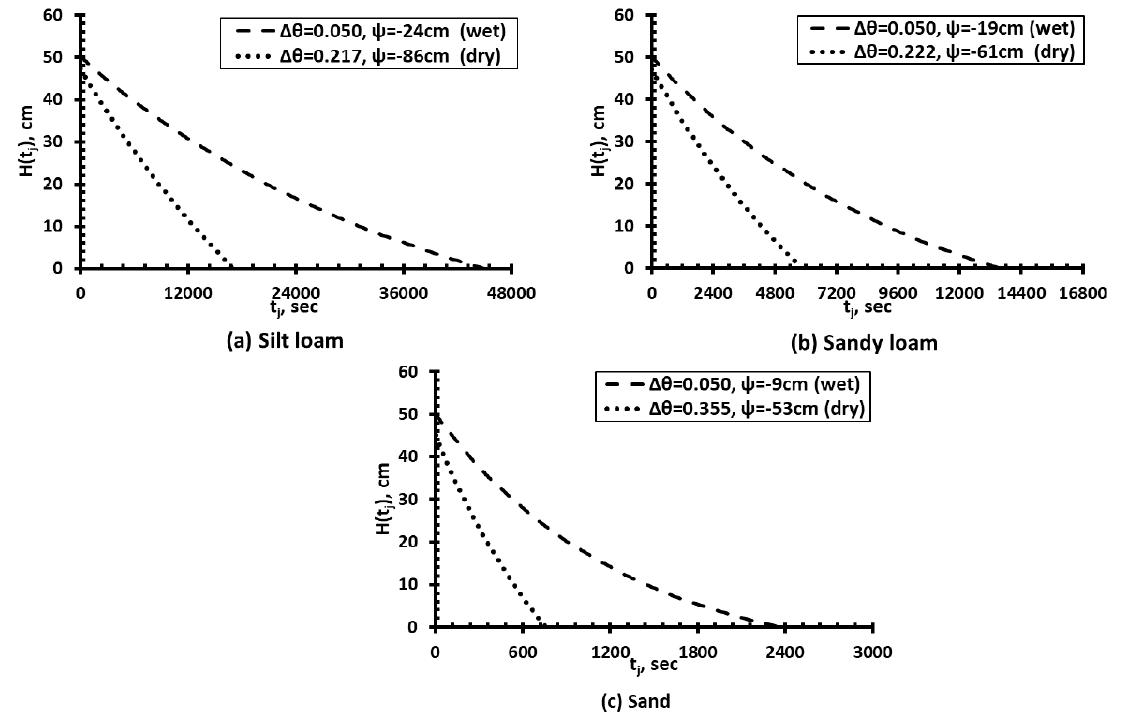
Figure 3. Drawdown curves for ( a ) silt loam, ( b ) sandy loam, and ( c ) sand estimated by the forward-modeling code using the soil properties K s and Ψ reported in Table 2 for two di ff erent values of ∆ θ representing wet and dry conditions. Three graphs ( a – c ) have di ff erent scales for the x-axis (time in sec).